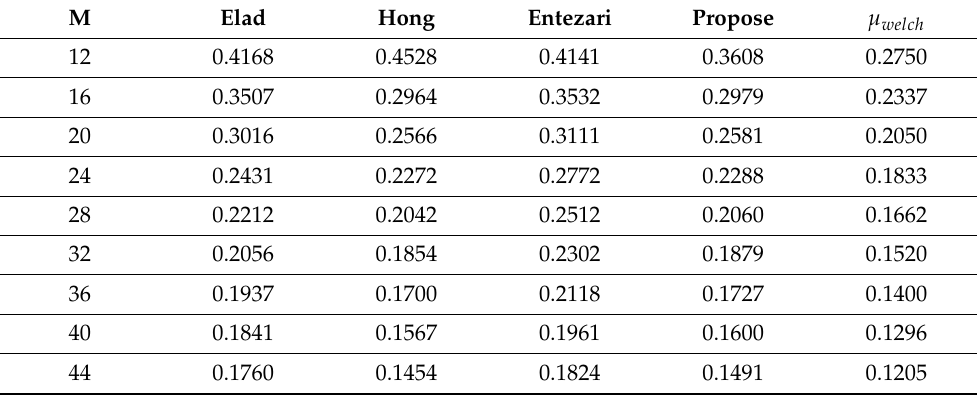
Table 2. µ ave by Elad, Hong, Entezari, and proposed method versus measurement dimension M